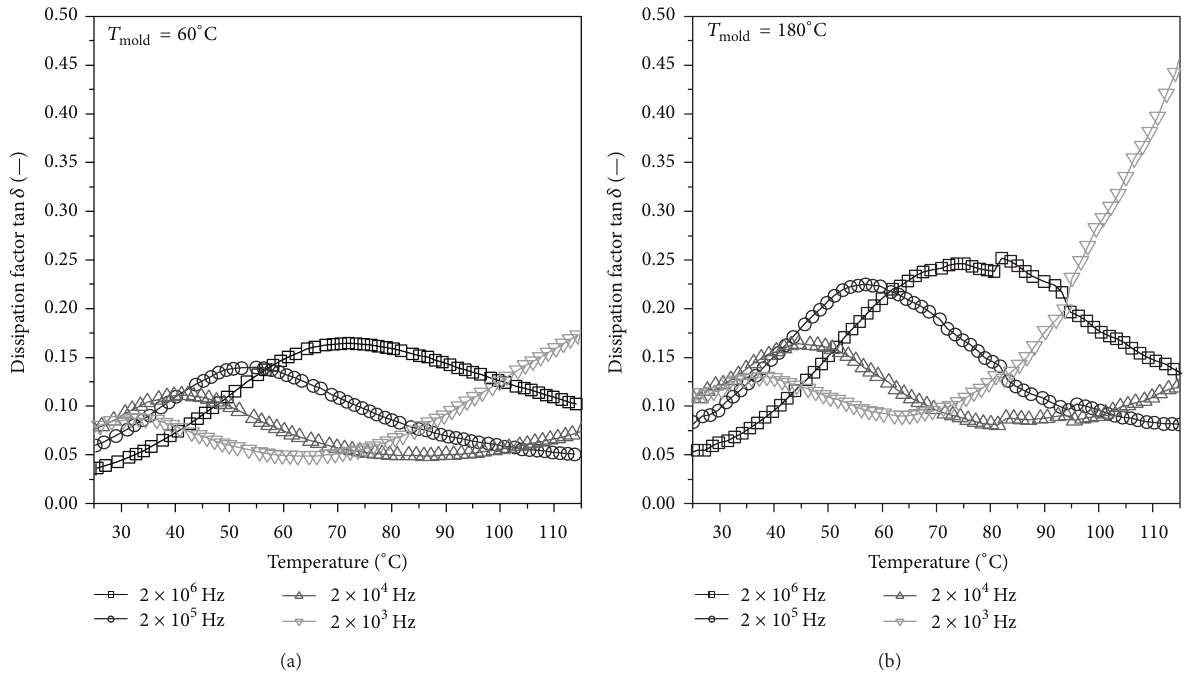
Figure 6: Dissipation factor tan 𝛿 at varied frequencies for the specimens injection moulded at 60 ∘ C and 180 ∘ C.